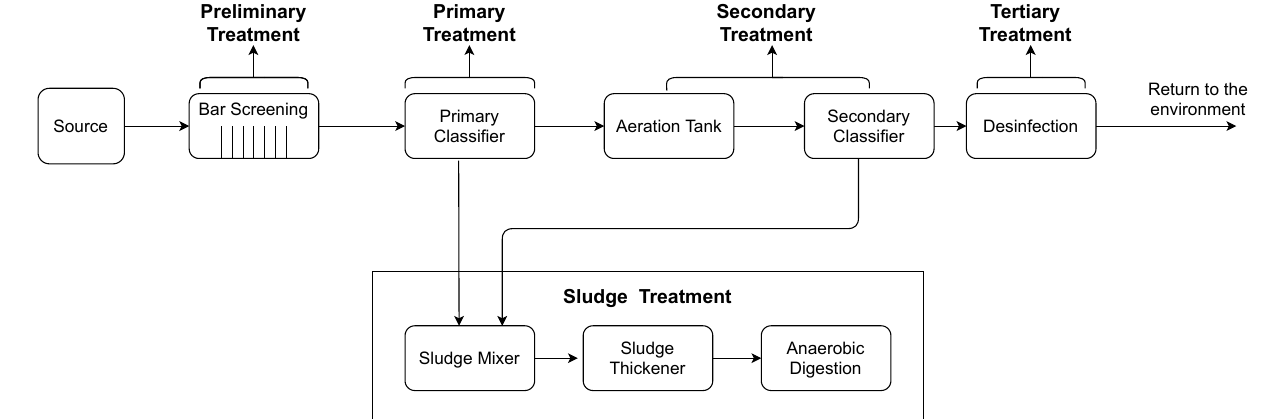
Figure 1. WWTP (Wastewater Treatment Plants)